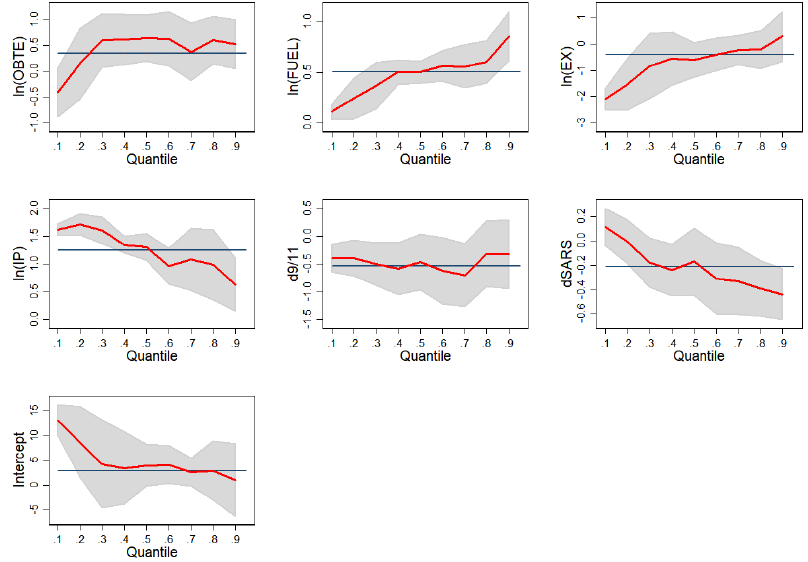
Figure 5. Model 2: Plot of the QR coefficient of the ASI